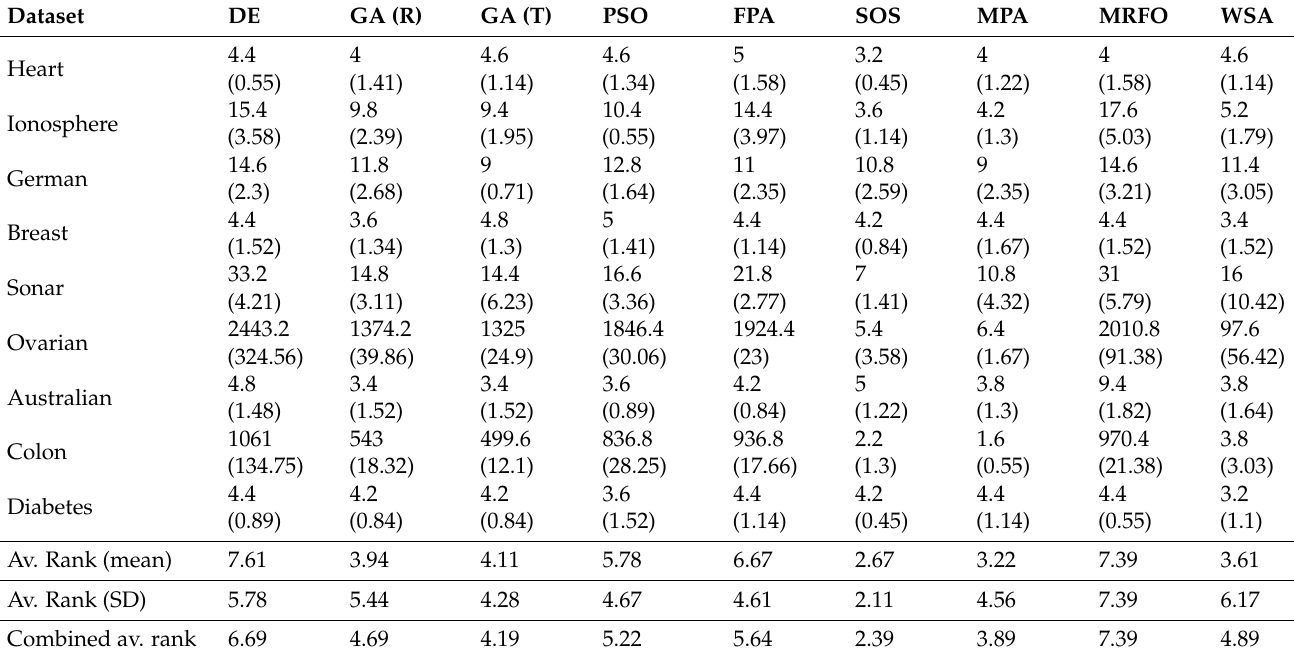
Table 10. Mean (and standard deviation) of features selected by each algorithm for each dataset on repeated trials.